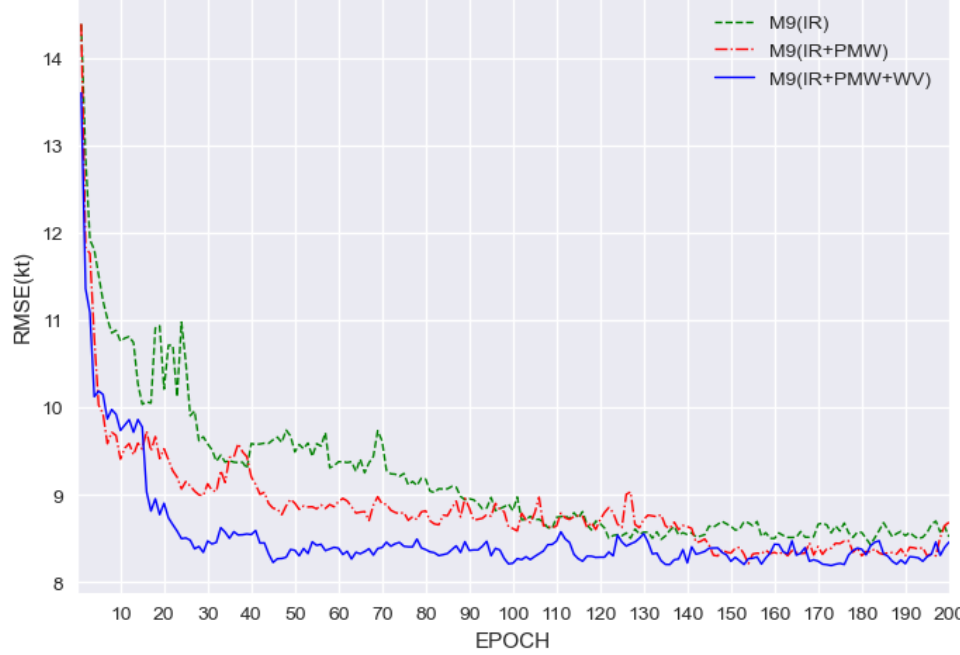
Figure 3. Learning curves of the best-performing model in the three ablation experiments in terms of